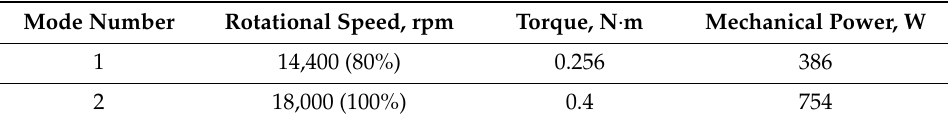
Table 1. Motor operating points.